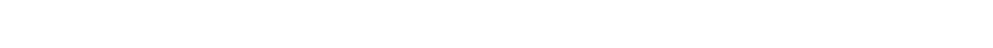
FIGURE 1 | Diagram of the health action process approach model with obtained Pearson correlations between relevant paths . Unless otherwise specified, for all correlations within the volitional phase n = 26, and n = 25 within the motivational